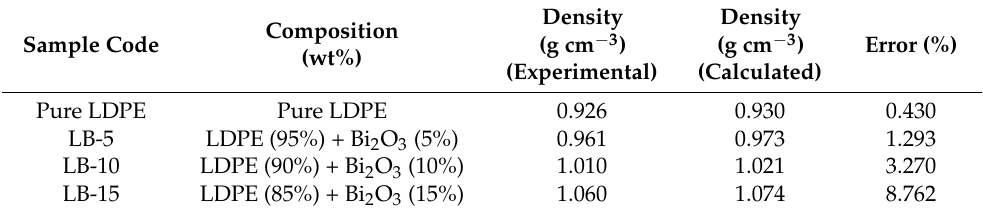
Table 1. The density results of LDPE and its